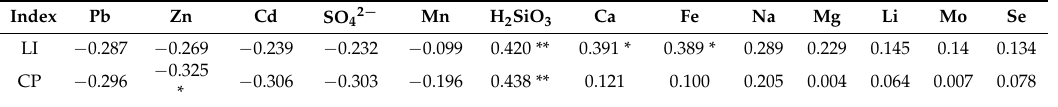
Table 6. Results of the correlation analysis of the centenarian prevalence, longevity index and trace element and mineral levels in drinking water.